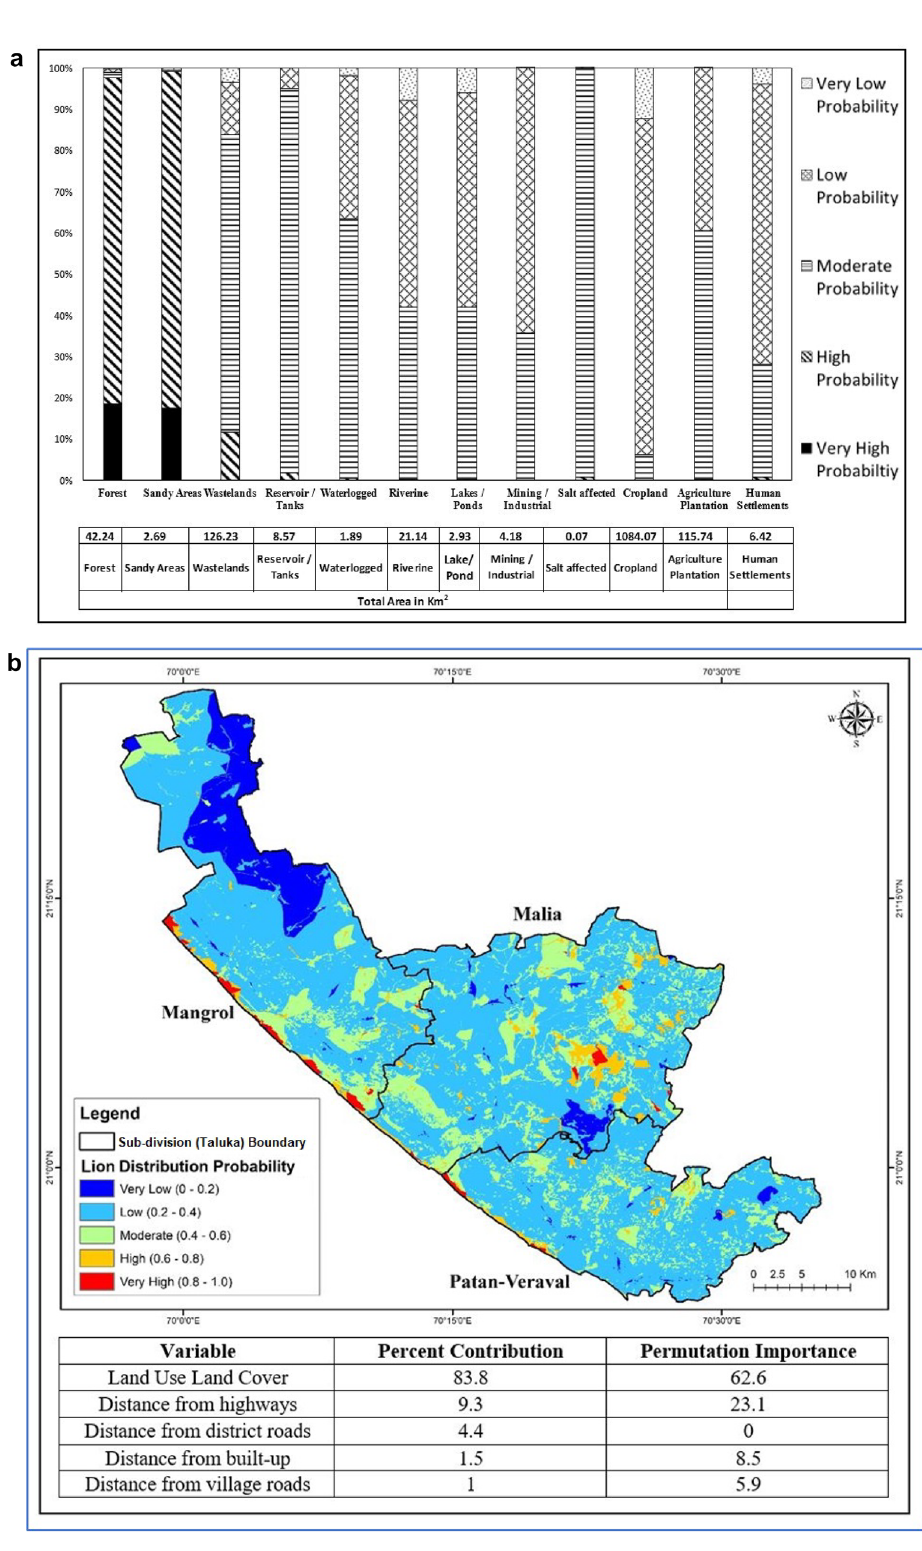
Figure 3. ( a ) The proportion (%) of very low to high probability areas under each LULC category in the western coastal lion habitat. The table indicates the total area (km 2 ) under each category in the western coastal lion habitat of the study area, covering 1413 km 2 . ( b ) Lion distribution map of lions ranging in the western coastal habitat based on MaxEnt models. Red colours indicate a higher “probability of occurrence” (suitability), while blue colours indicate lower probabilities. Using the MaxEnt logistic output, the percent contribution and permutation Importance are shown in the table. LULC was found to contribute the majority